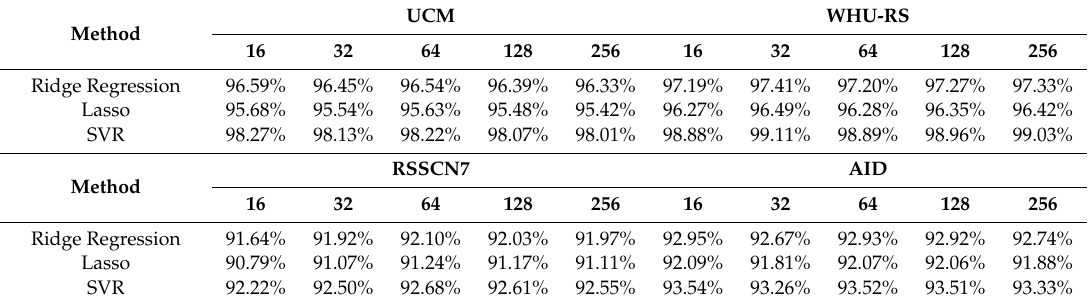
Table 3. Performance comparison of Support Vactor Regression (SVR) and other regression methods.